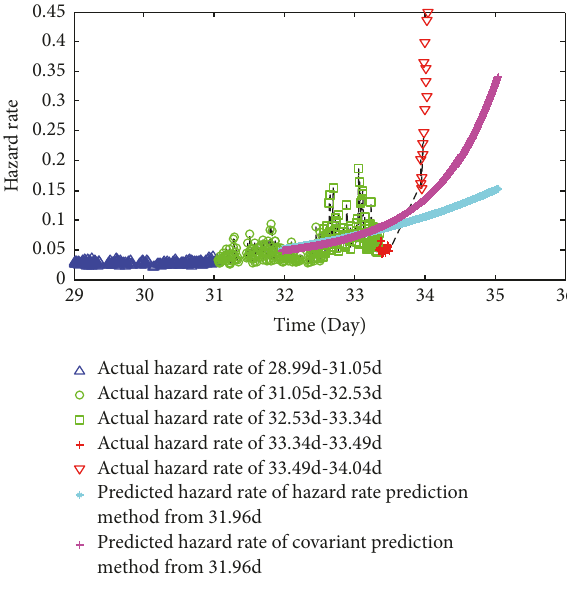
Figure 17: The trend prediction result of period (d).